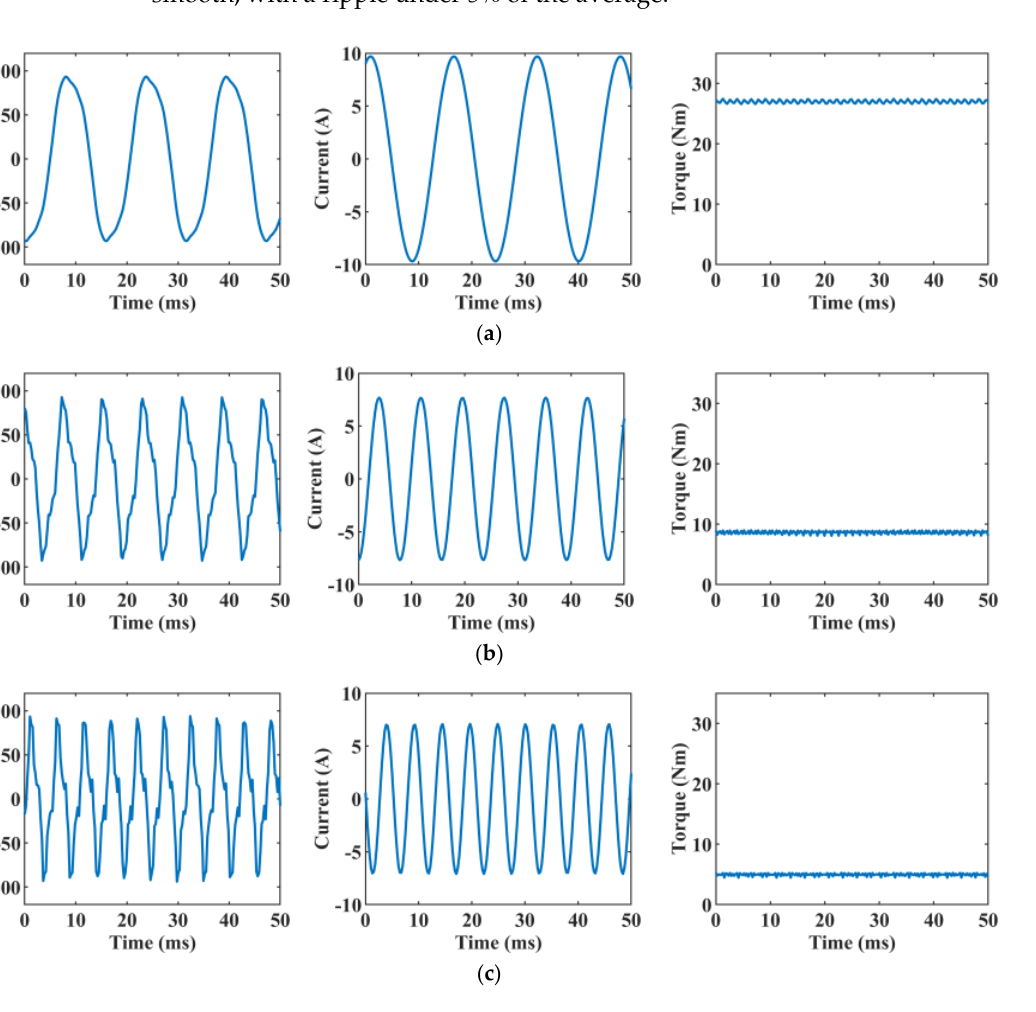
Figure 14. VSCAVC steady-state characteristics of the selected 12/7 design with different rotor speeds and initial phase angles (in electrical degree). ( a ) Ω = 500 rpm, 𝜙 = 0° ; ( b ) Ω = 1000 rpm, 𝜙 = 108° ; ( c ) Ω = 1500 rpm, 𝜙 = 120° .